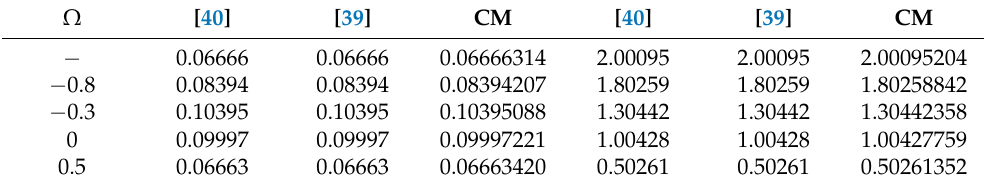
Table 2. Assessment of the projected outcomes for f (cid:48)(cid:48) ( 0 ) and g (cid:48) ( 0 ) with existing results [39] and homotopic analysis method (HAM) [40] for φ = A 1 = A 2 = 0, Re = 1 and for different values of Ω . Ω